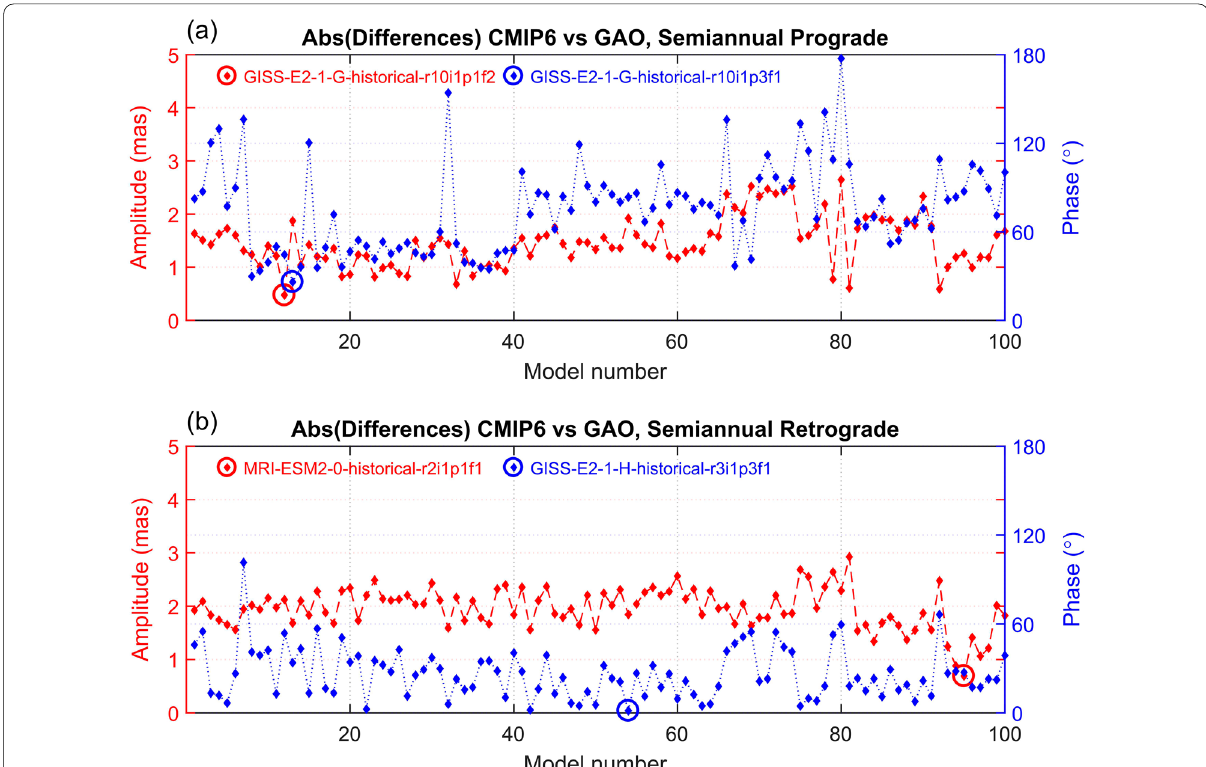
Fig. 7 Absolute values of differences in amplitudes and phases between CMIP6-based HAM and GAO for a semiannual prograde oscillation and b semiannual retrograde oscillation. The models for which the amplitude and phase differences are the smallest are indicated by circles and